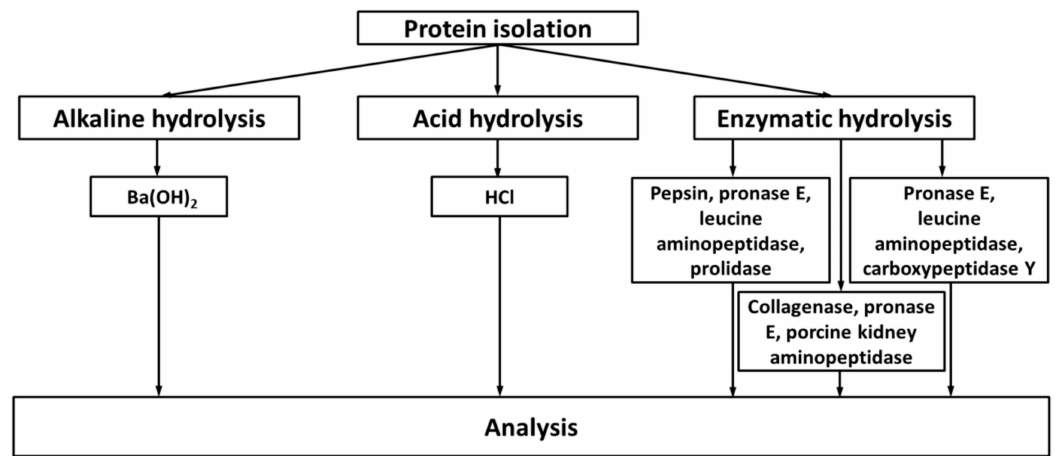
Figure 3. The overview of protein hydrolysis workflows (alkaline [99], acid [19,115] and enzymatic [19,115,116]), compatible with subsequent chromatography-based analysis. Concentrations: Ba(OH) 2 , 1.7 mol/L [99]; HCl, 6 N [19,115]; pronase E, two additions of 0.3 unit [19], 400 PU